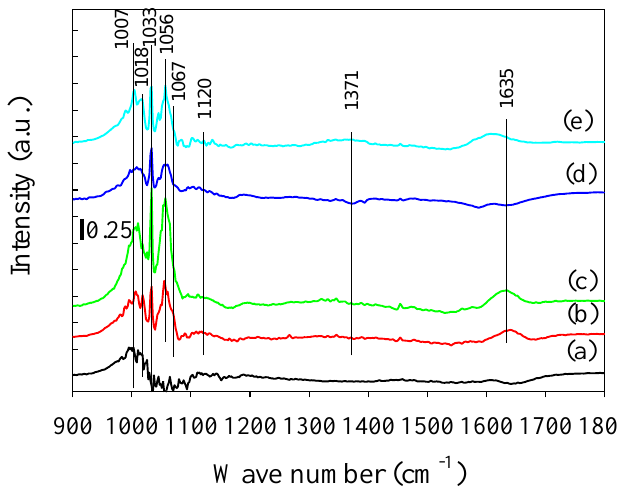
Figure 6. In situ DRIFT spectra of Au/La 2 O 3 /Al 2 O 3 catalysts after methanol adsorption at 160 °C and subsequent He purge for 5 min: (a) La 2 O 3 /Al 2 O 3 ; (b) Au/La 2 O 3 /Al 2 O 3 (H); (c) Au/La 2 O 3 /Al 2 O 3 (S35); (d) Au/La 2 O 3 /Al 2 O 3 (S115); (e) Au/La 2 O 3 /Al 2 O 3 (G).